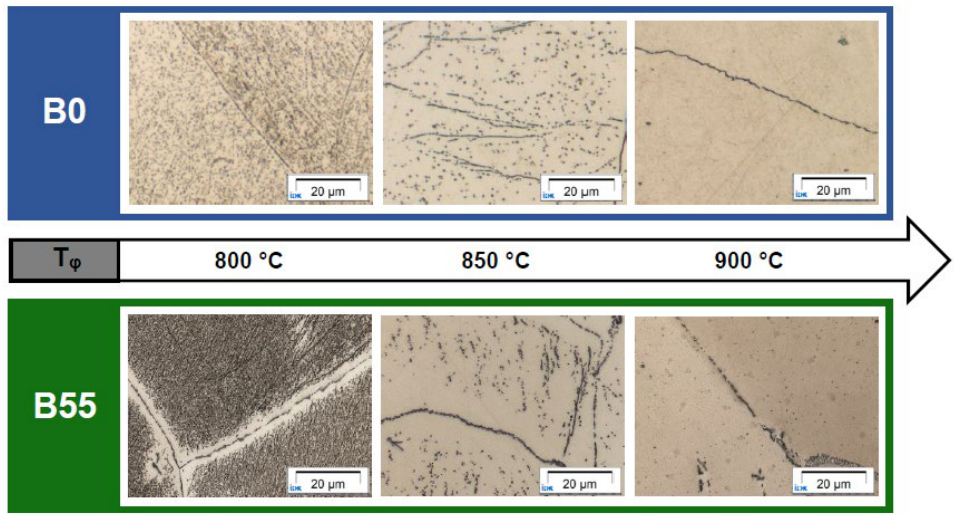
Figure 3. Impact of the deformation temperature of 800 °C/850 °C/900 °C with a 0.5 deformation grade of the reference B0 in comparison to the boron-alloyed B55 steel.